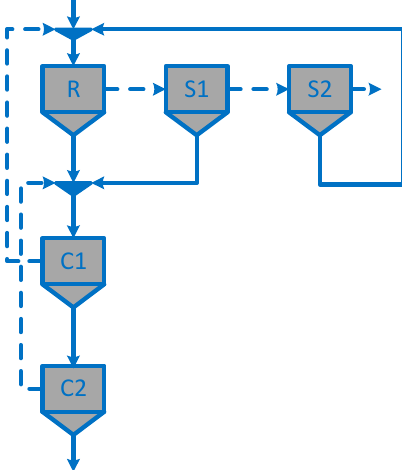
Figure 4. Structure obtained by maximizing the net present worth.